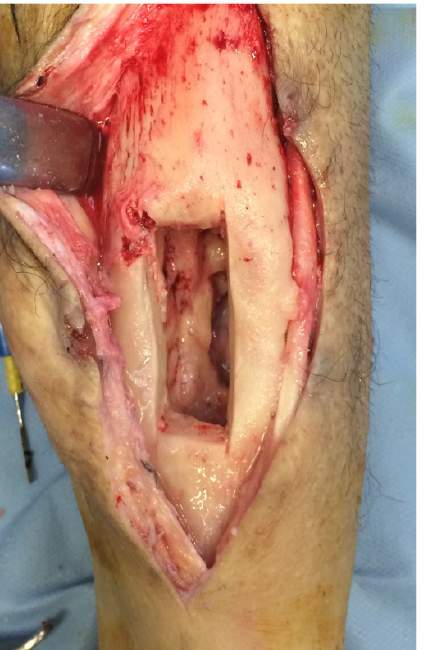
Figure 2. Rectangular bone window.